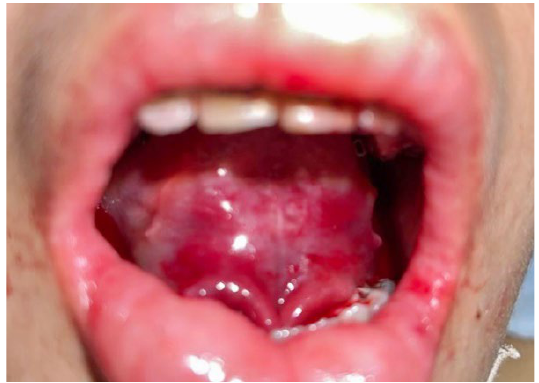
Figure 3. Progressing sublingual swelling prior aggressive packing and pressure.